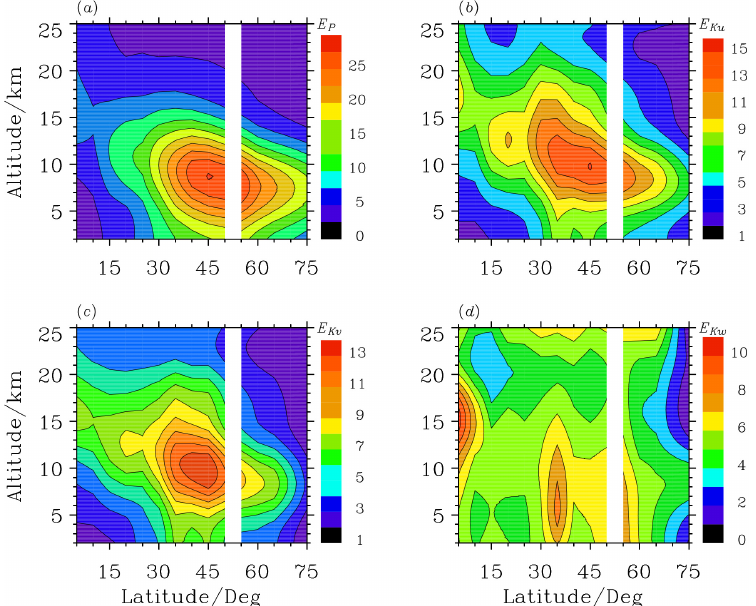
Figure 3. Latitudinal and vertical variations of 11-year averaged gravity wave potential energy density (a) , zonal kinetic energy density (b) , meridional kinetic energy density (c) and vertical fluctuation energy density (d) . The zonal and meridional kinetic energy densities and potential energy density are in Jm − 3 ; the vertical fluctuation energy is in 10 − 2 Jm − 3 . The blanks denote no measurements.